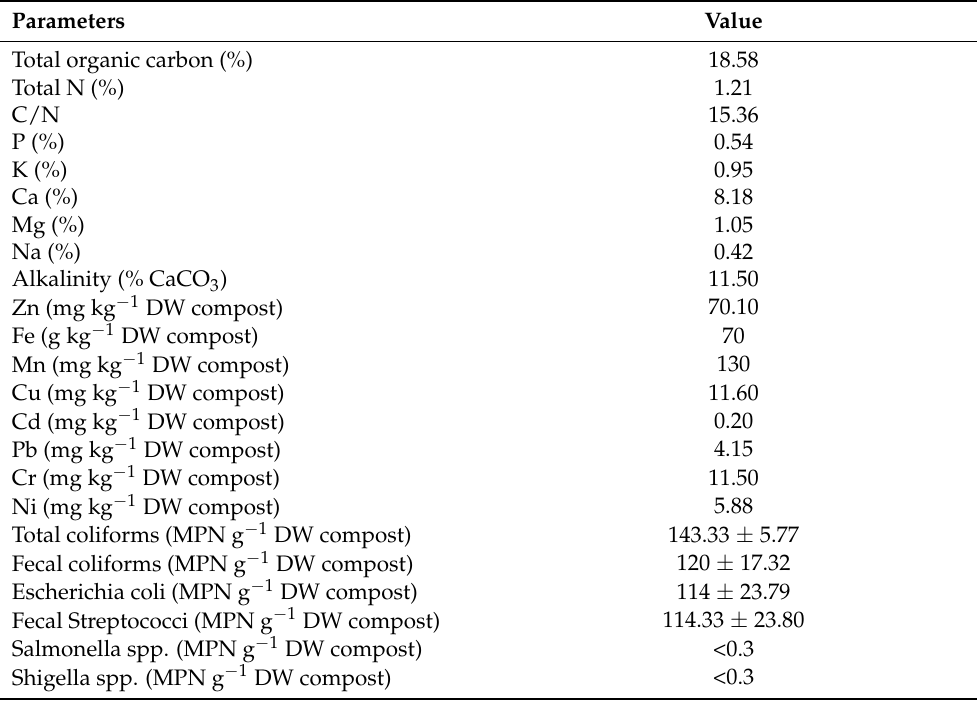
Table 2. Characteristics of date palm waste